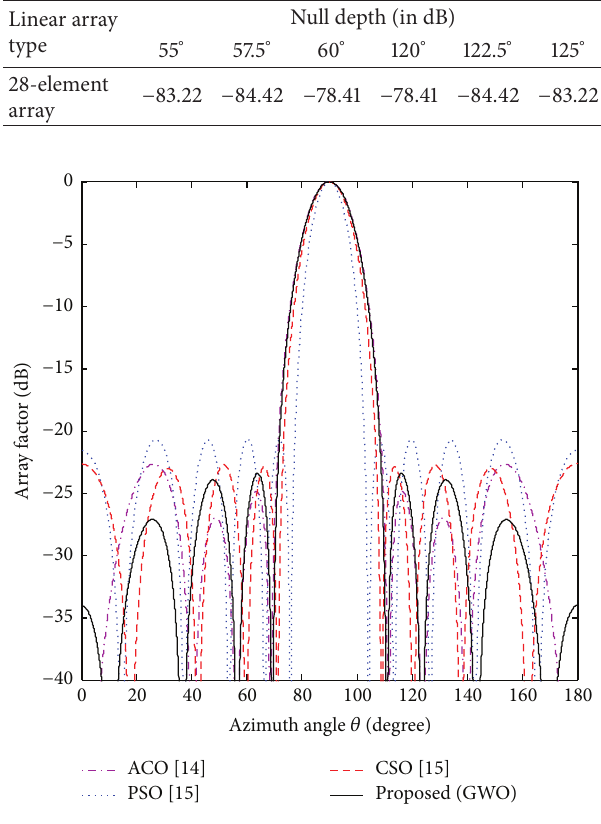
Figure 3: Array pattern for Example 1.